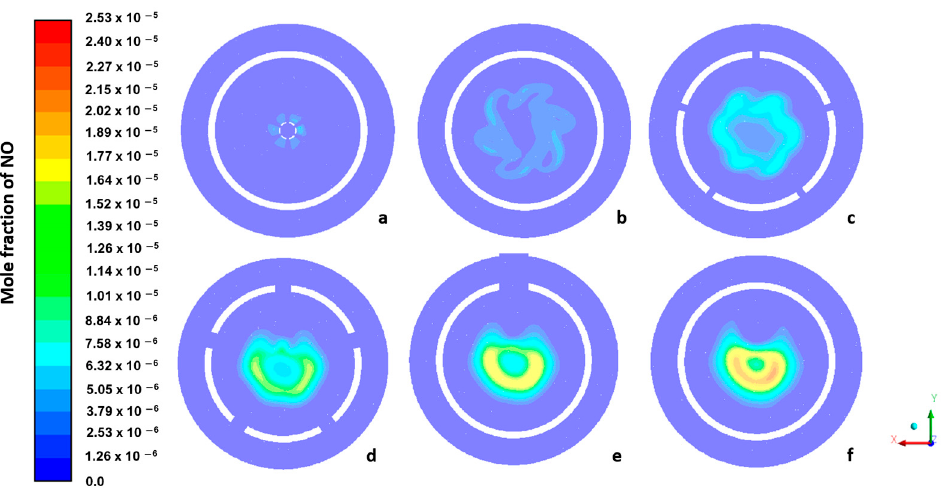
Figure 14. Mole fraction profiles of NO for transverse planes: ( a ) plane 1; ( b ) plane 2; ( c ) plane 3; ( d ) plane 4; ( e ) plane 5; ( f ) plane 6.